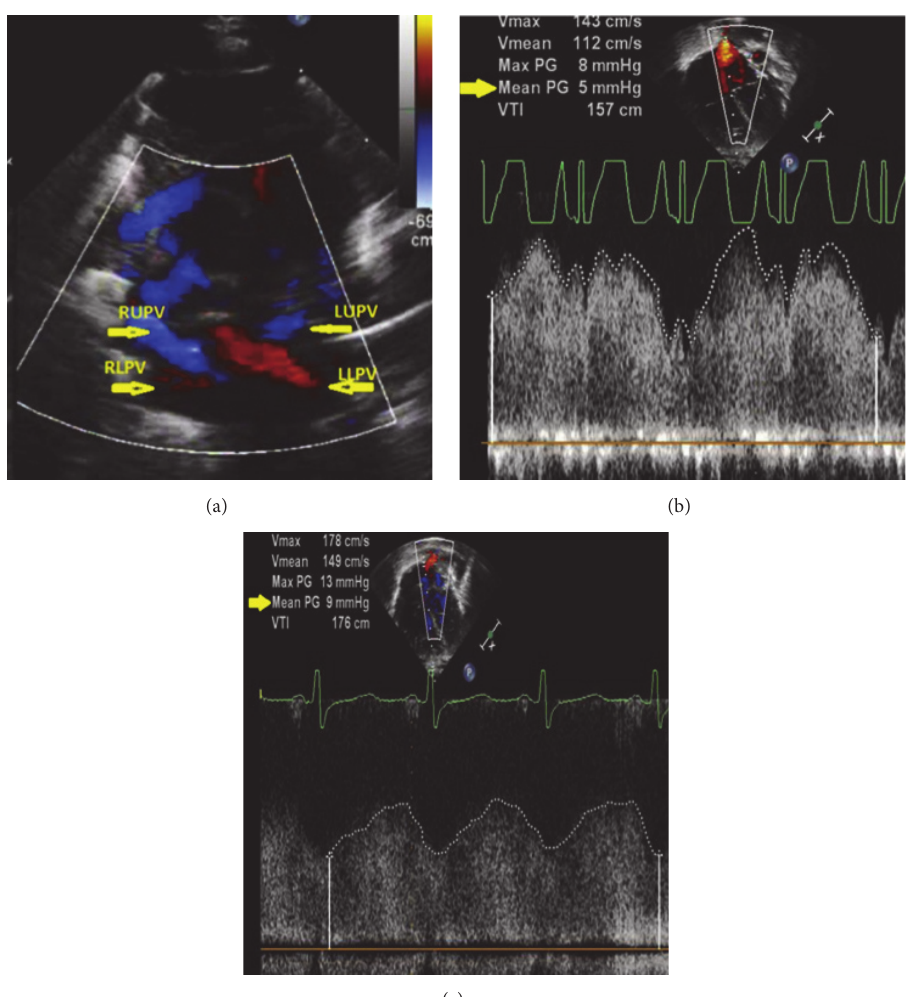
Figure 1: Transthoracic echocardiogram images demonstrating progressive pulmonary vein stenosis. (a) Color flow Doppler of pulmonary veins at initial diagnosis, with (b) measured mean pulmonary gradient (mean PG) of 5mmHg and (c) increased mean pulmonary pressure gradient to 9mmHg by 6 weeks after